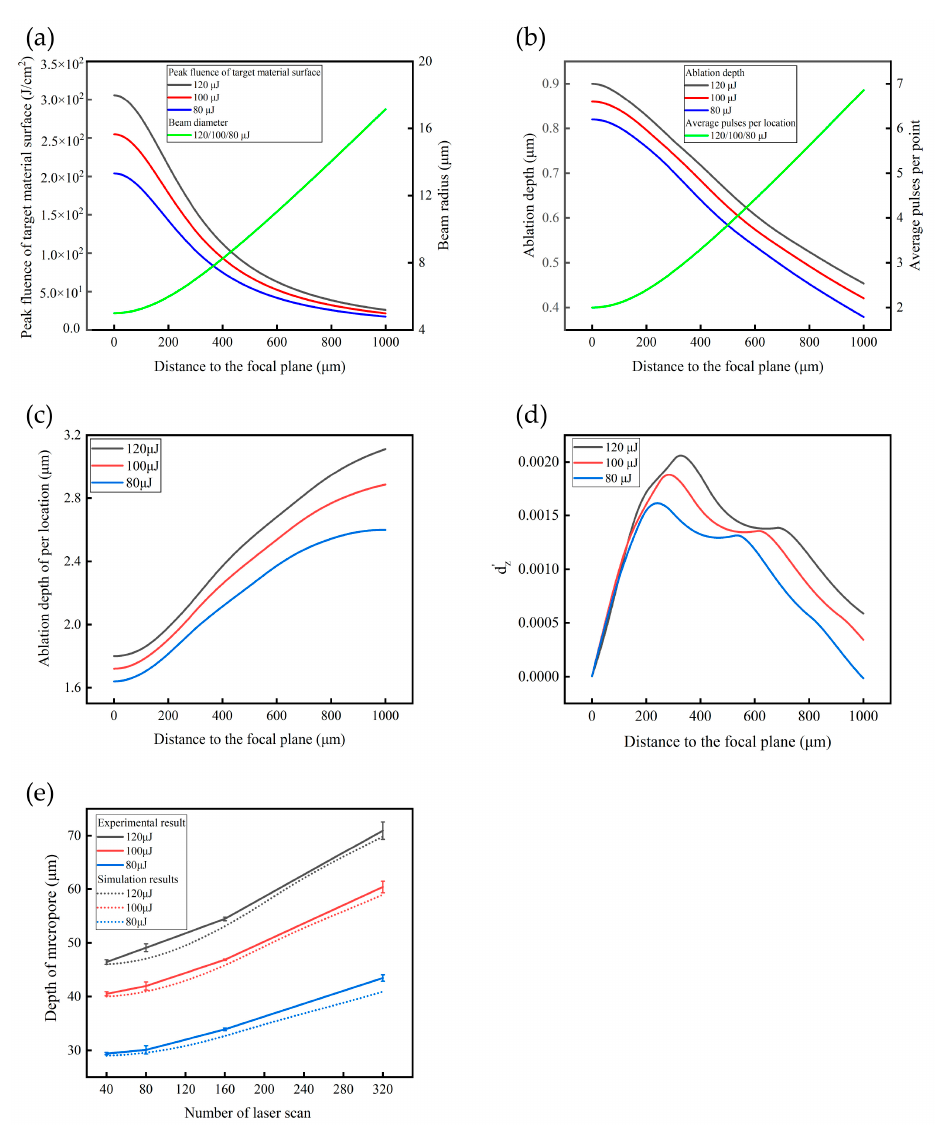
Figure 5. ( a ) Variation of laser fluence (three descending curves) and beam radius (increasing curve) with distance from the focal plane; ( b ) variation of ablation (three descending curves) and average pulses per point (increasing curve) with distance from the focal plane; ( c ) variation of ablation depth of single point with distance from the specimen upper plane; ( d ) variation of the derivative of the effective ablation depth with distance from the specimen upper plane; ( e ) variation of micro-pore depth with the number of laser scans: simulation and experimental results.